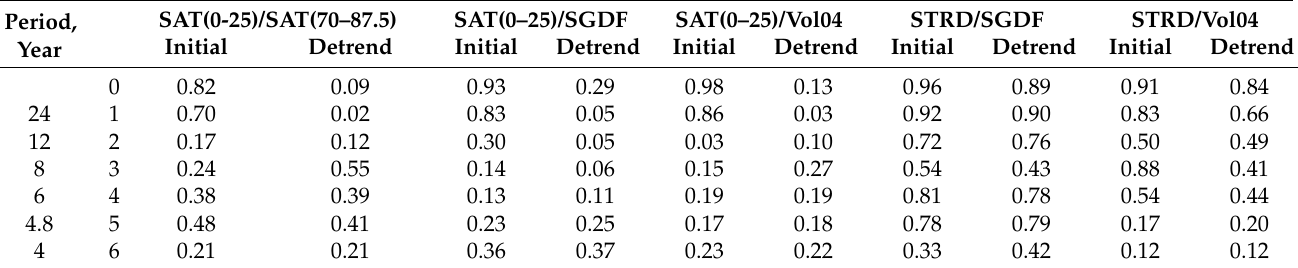
Table 2. Coherence between climatic variables before (Initial) and after (Detrend) removing trend. Period, Year